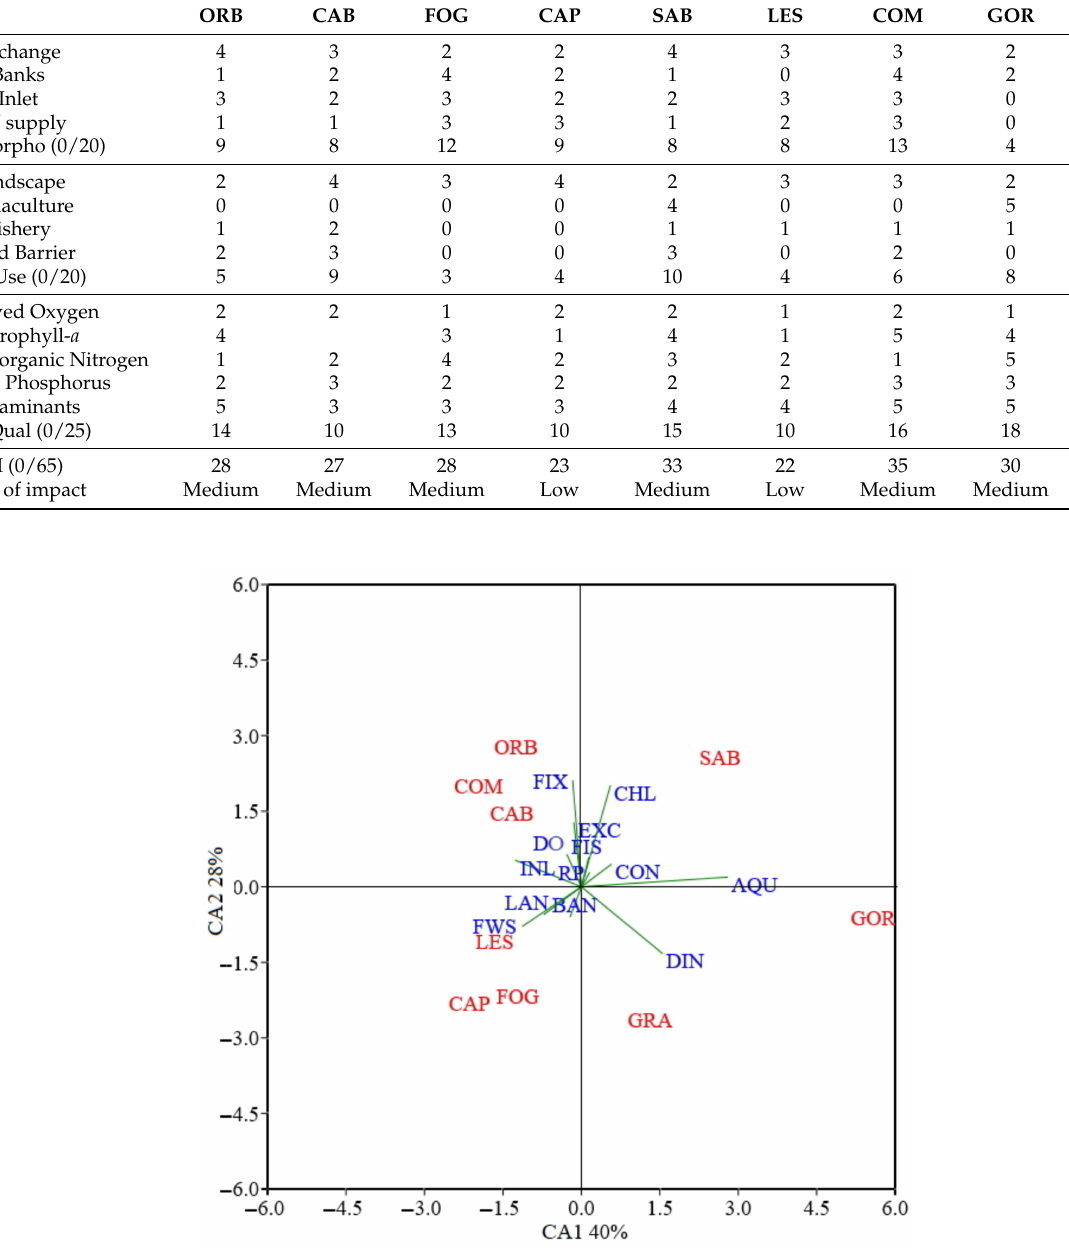
Figure 3. Ordination plot of Principal Component Analysis (PCA) for pressure indicators (blue) in the sites under study (red). Coastal lagoons and vectors for anthropogenic pressures are